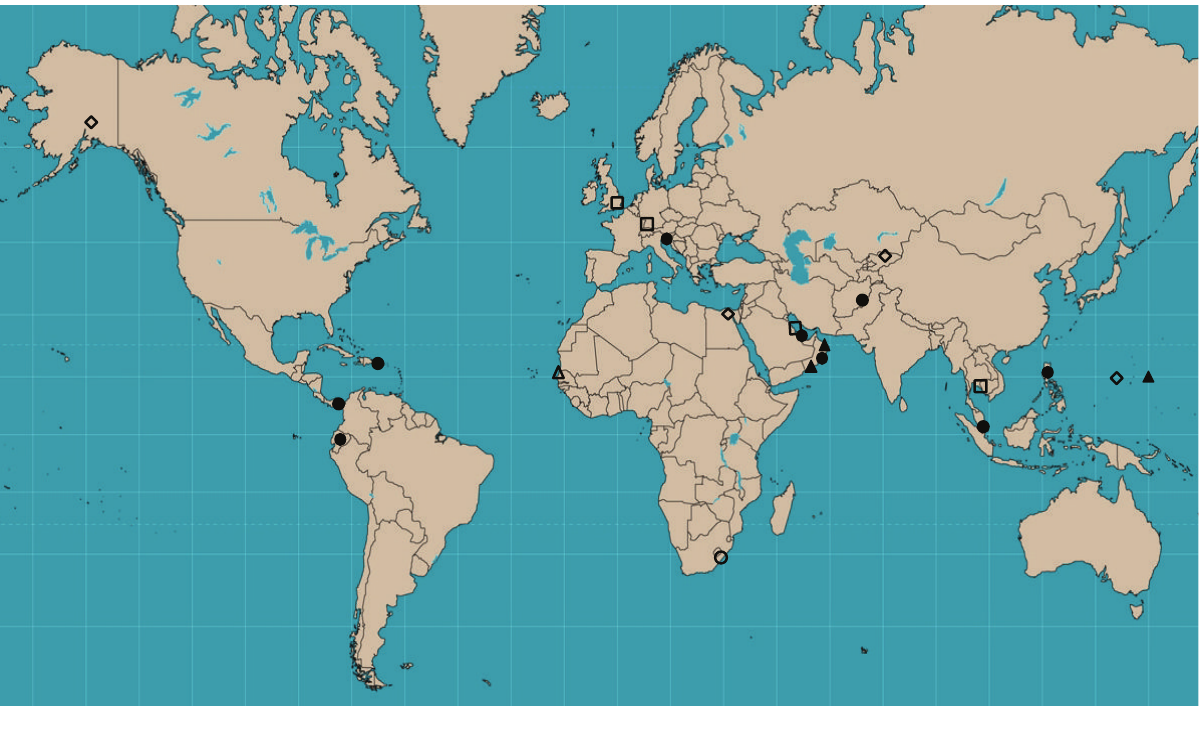
Figure 2: Utilized FSLs, across all model